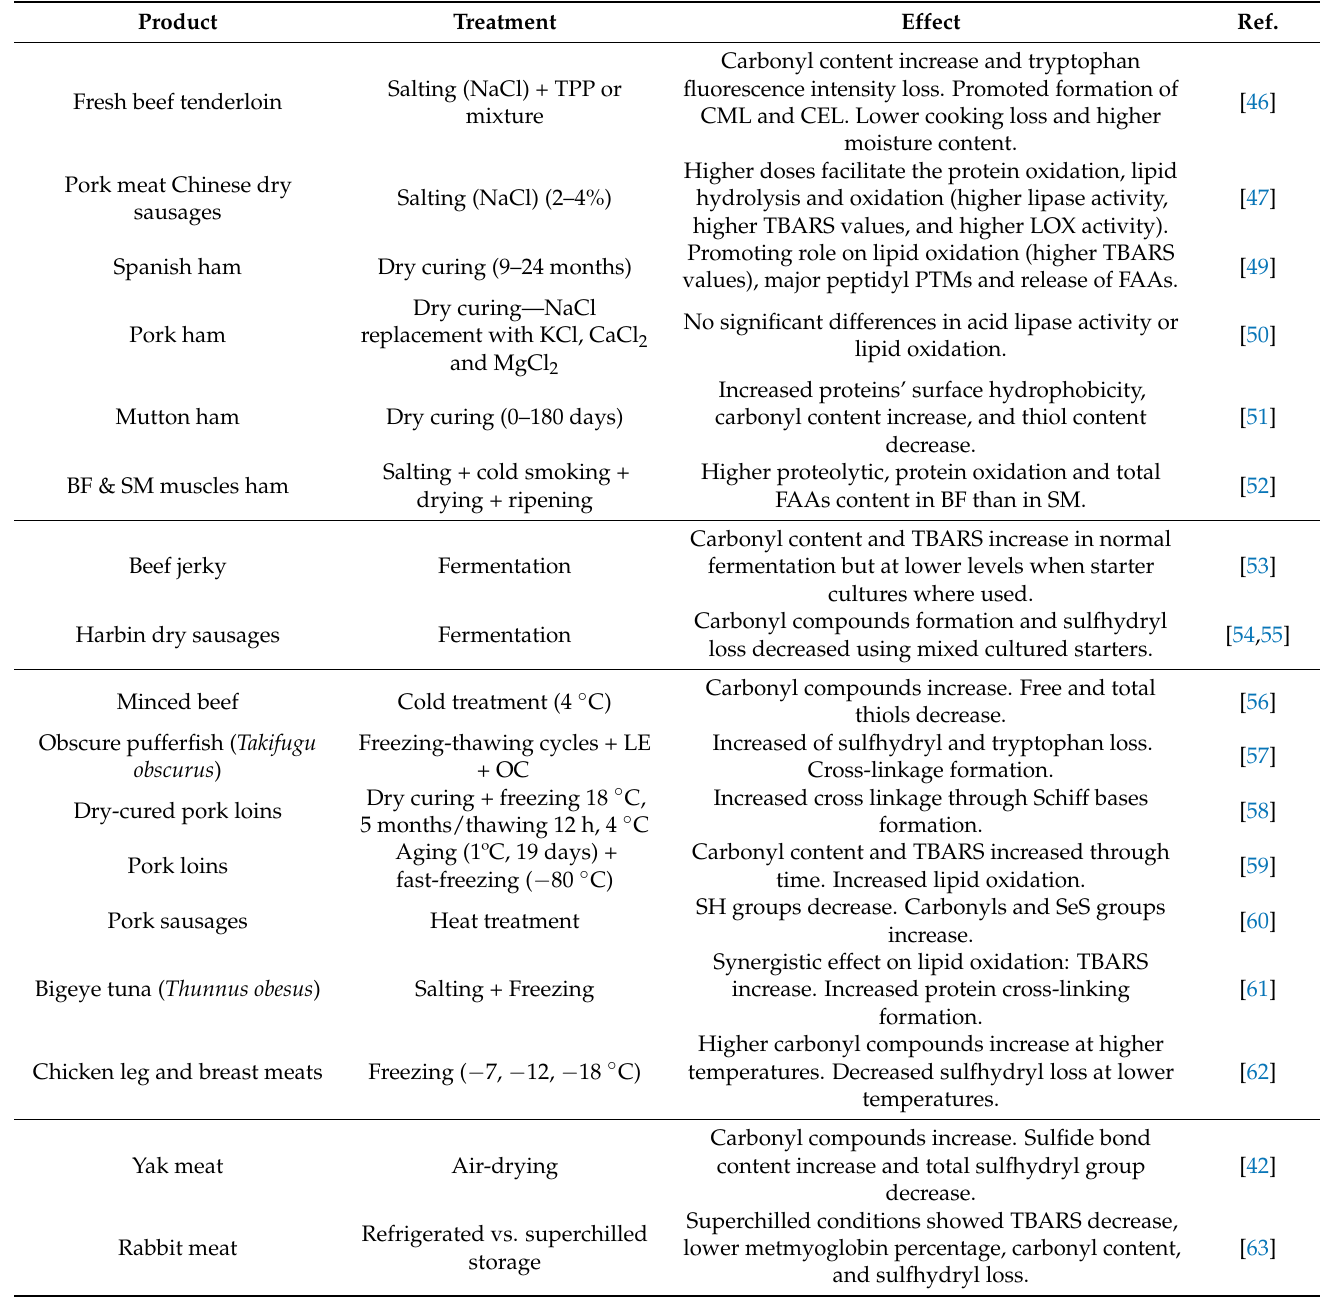
Table 1. Studies evaluating extrinsic factors on protein oxidation in different muscle